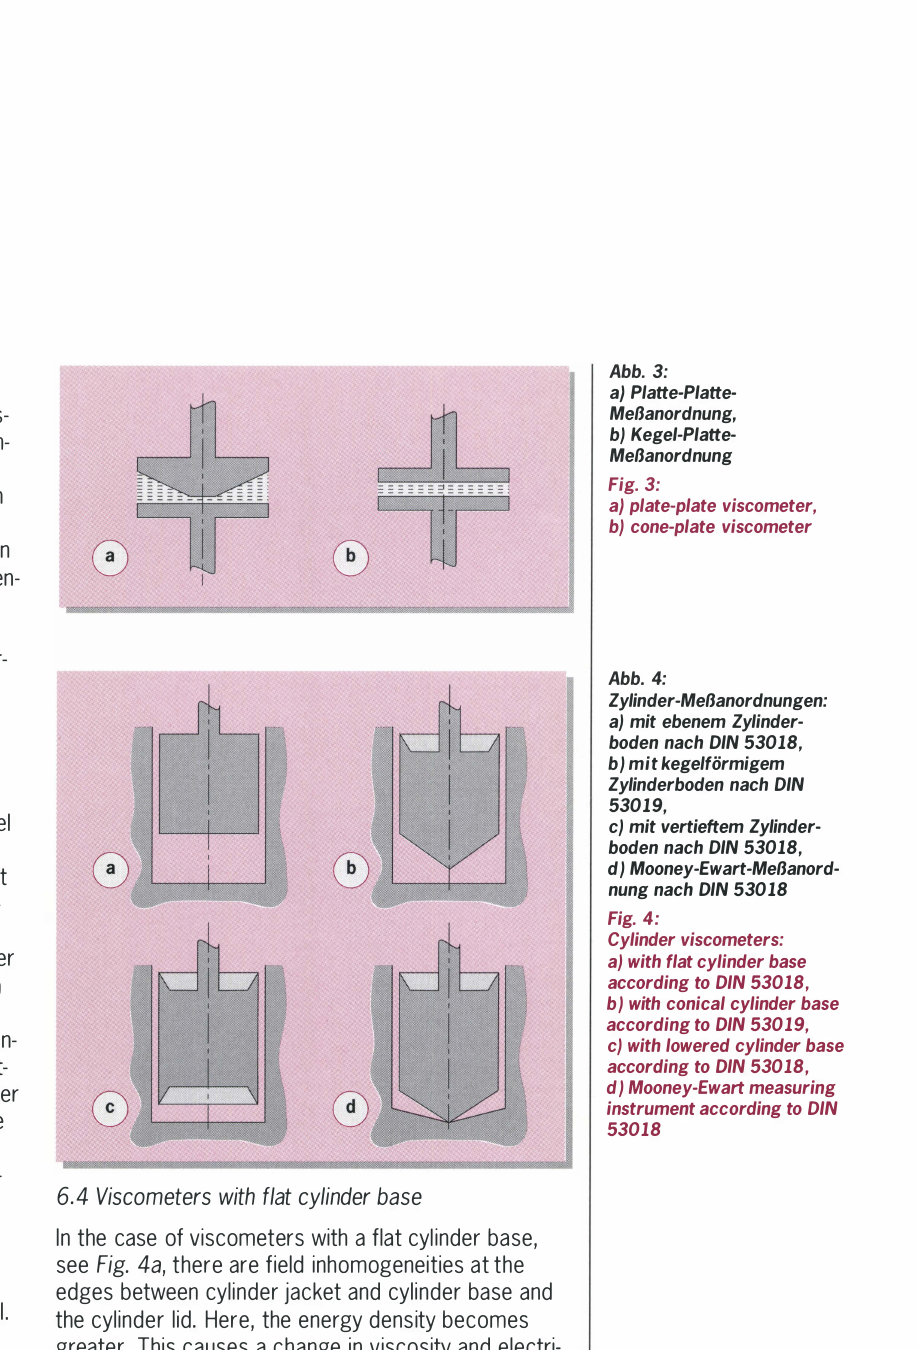
Fig. 3: a] plate-plate viscometer,